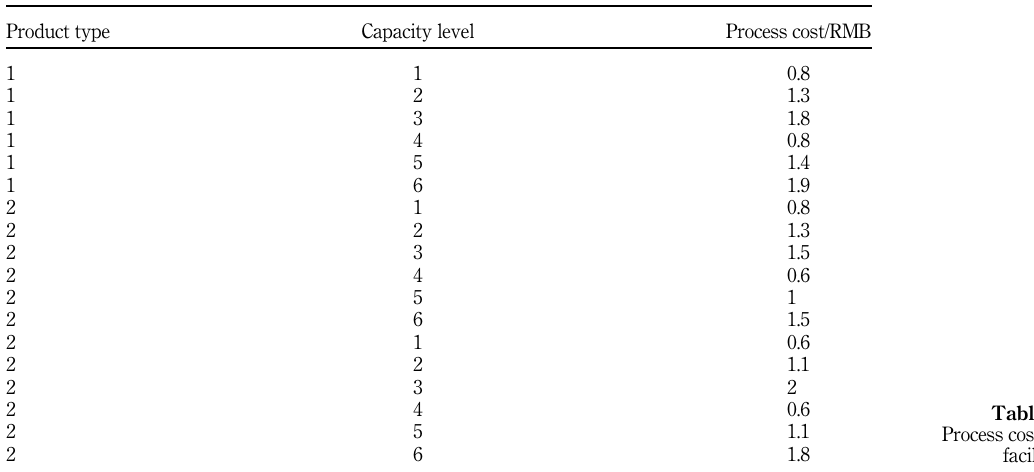
Table II. Process costs